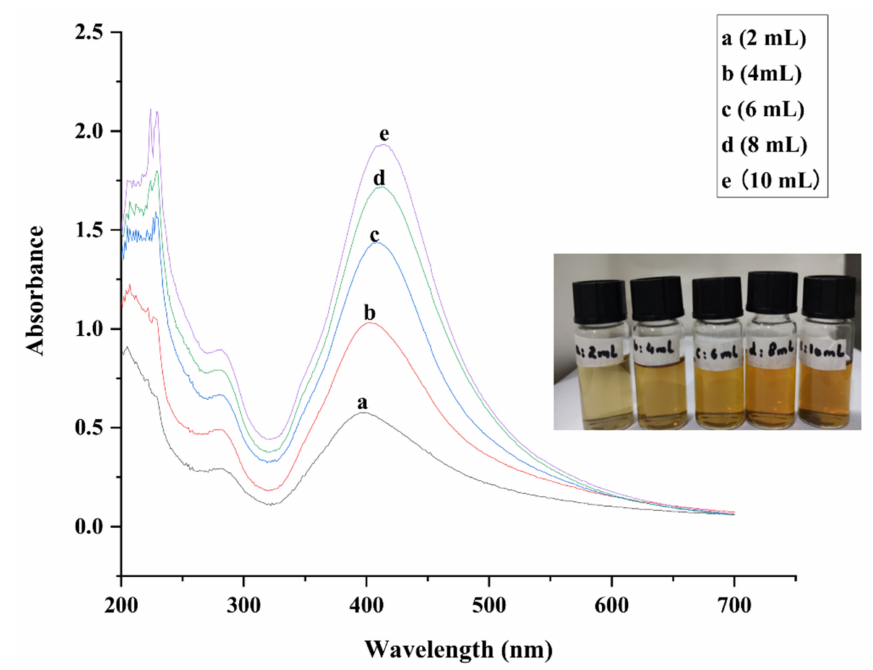
Figure 3. UV-Vis spectra taken at different volumes of AgNO 3 and arbutin